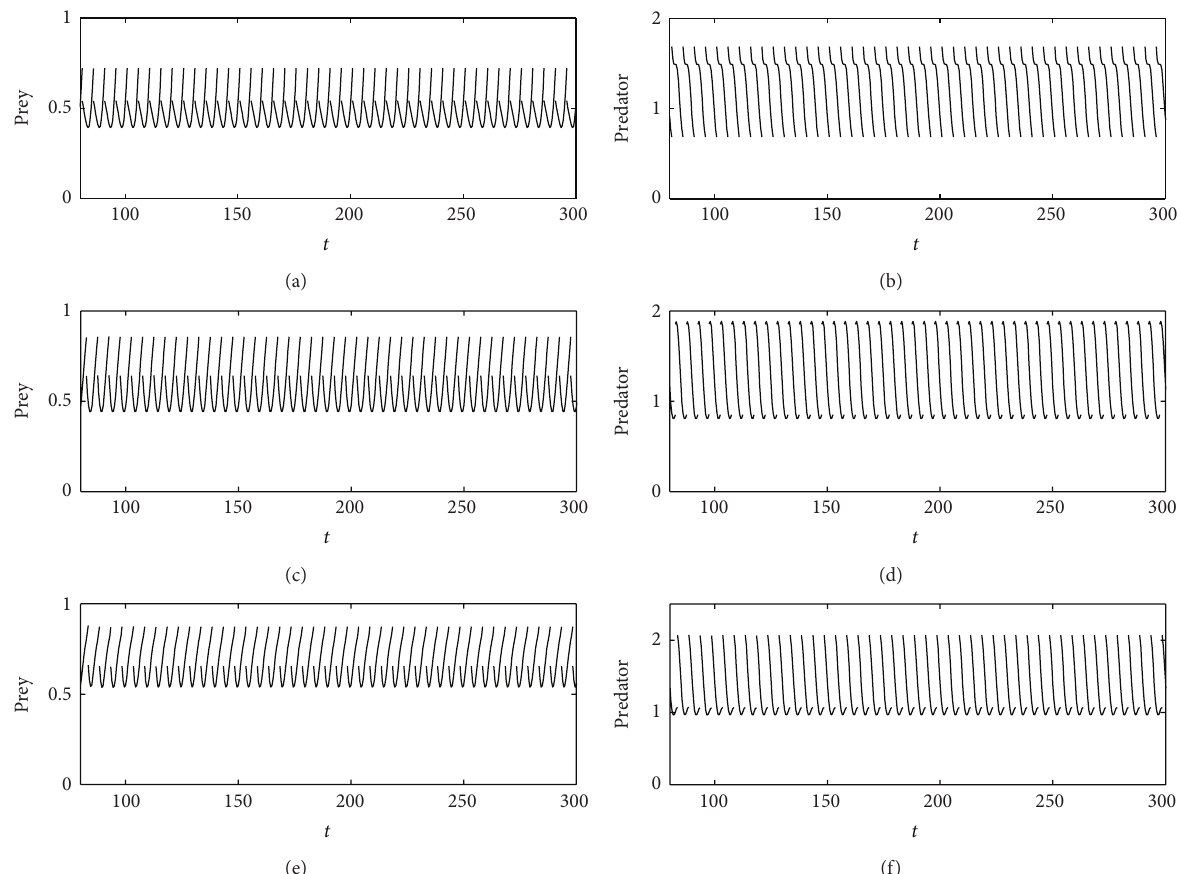
Figure 2: Supposing that one-pulse controlling is implemented in each period 𝑇 , we plot the solution curve of system (4). We fixed all parameters as follows: 𝑟(𝑡) = 0.7 + 0.1 cos (0.4𝜋𝑡) , 𝑎(𝑡) = 1/(50 + 9 sin (0.4𝜋𝑡)) , 𝑏(𝑡) = 0.5 + 0.02 sin (0.4𝜋𝑡) , 𝑐(𝑡) = 0.5𝑏(𝑡) , 𝛿(𝑡) = 0.3 +